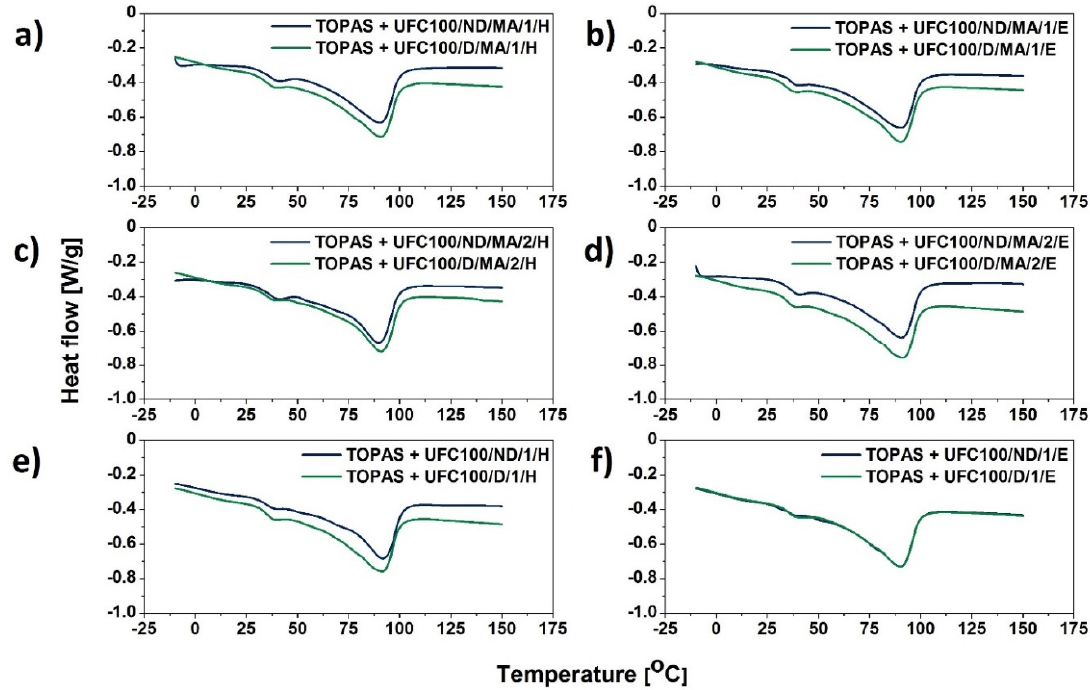
Figure 5. DSC curves of blend samples filled with cellulose fibers: ( a ) solvent exchanged to hexane and then MA treated; ( b ) solvent exchanged to ethanol and then MA treated; ( c ) MA treated and then solvent exchanged to hexane; ( d ) MA treated and then solvent exchanged to ethanol; ( e ) solvent exchanged to hexane; ( f ) solvent exchanged to ethanol.